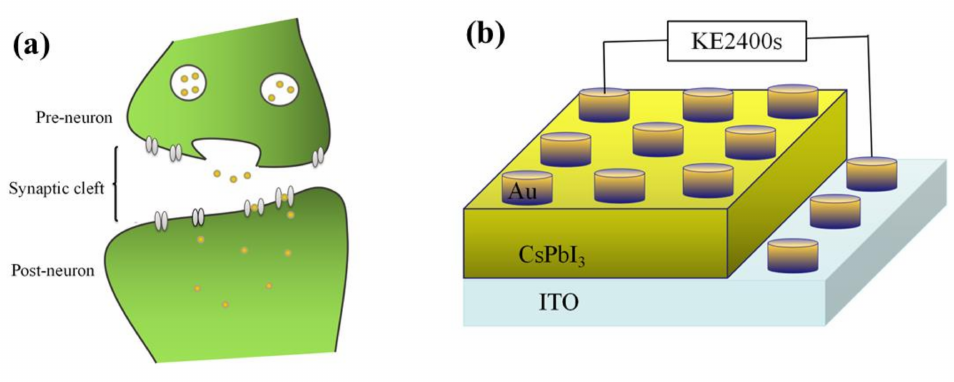
Figure 3. ( a ) A pair of synapses in biology; ( b ) the structure of the artificial synapse is Au/CsPbI 3 /ITO. The top electron is Au, and the bottom electron is